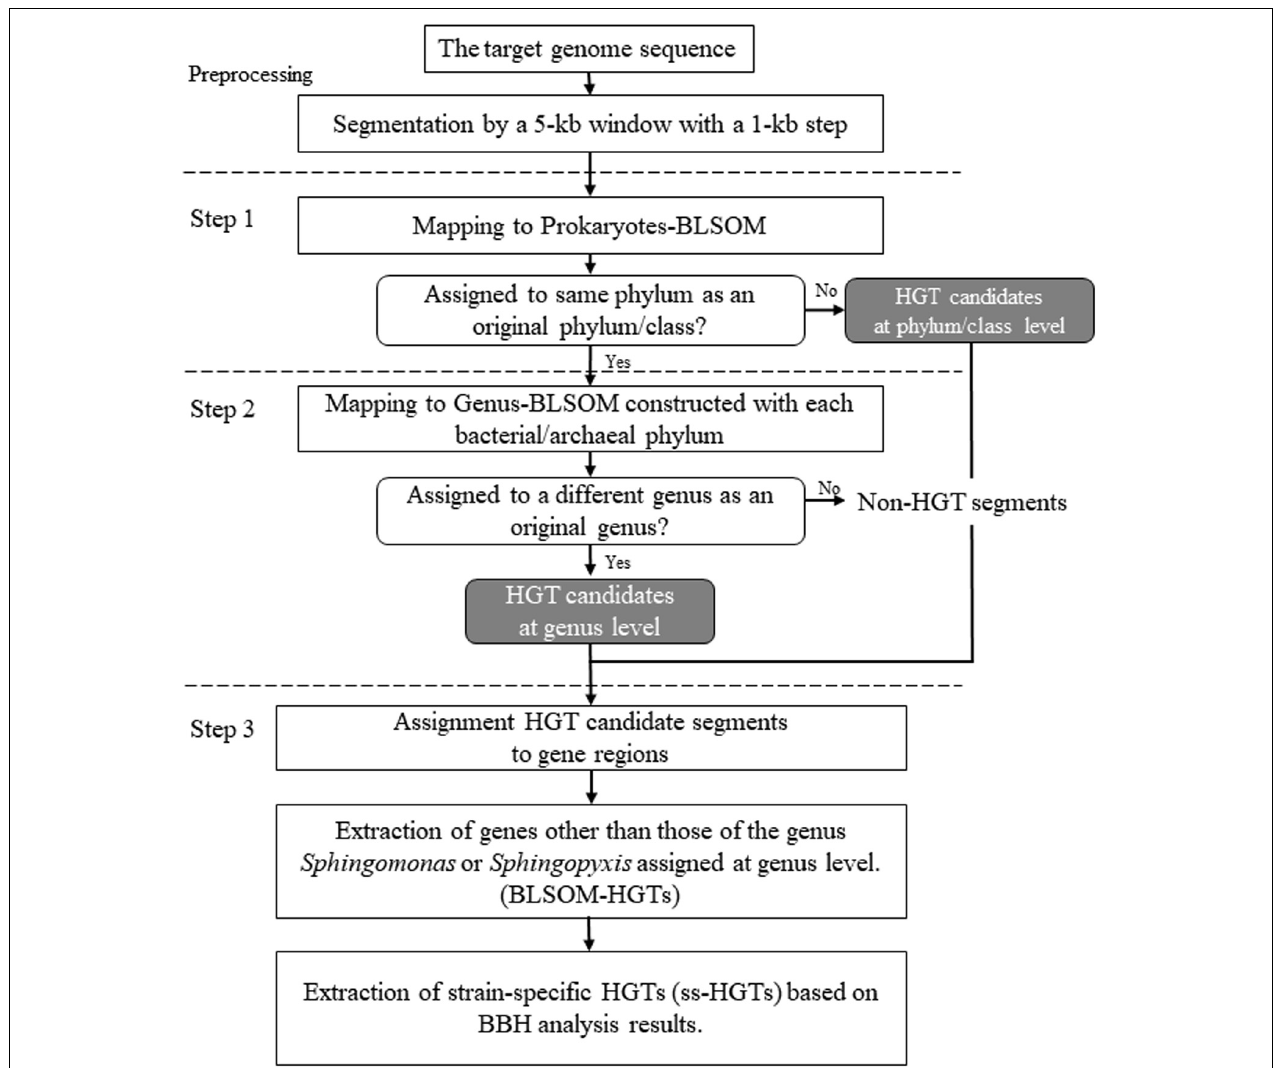
FIGURE 1 | Workflow for detecting HGT candidates in the microbial genomes using